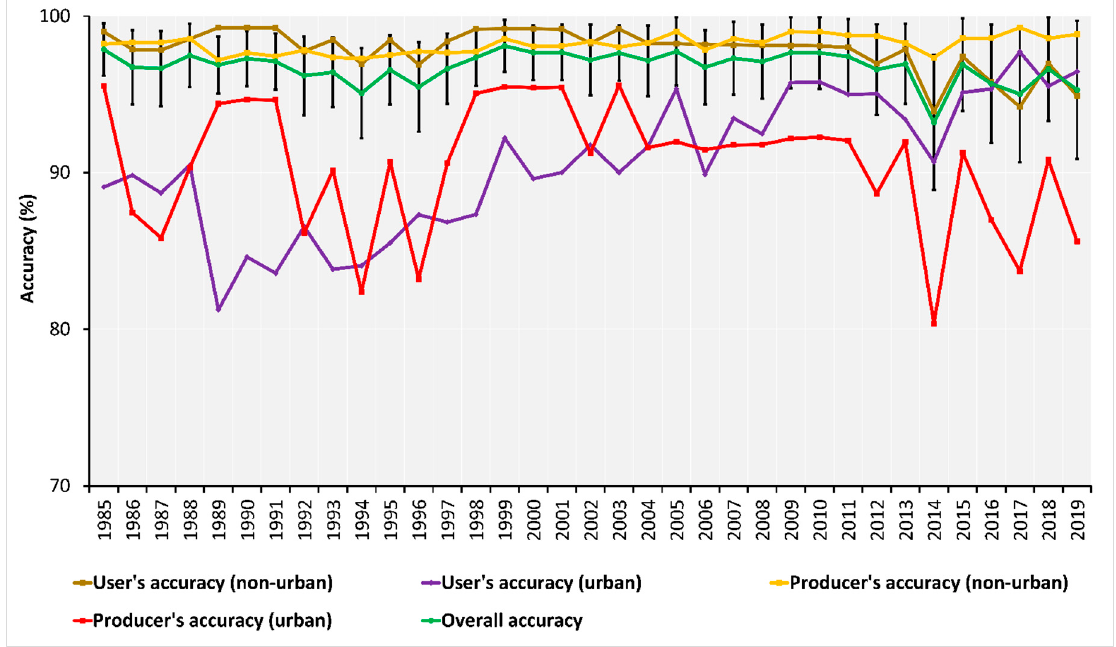
Figure 6. The user’s, producer’s, and overall accuracies from 1985 to 2019 (95% confidence intervals are represented by the error bars for overall accuracy).